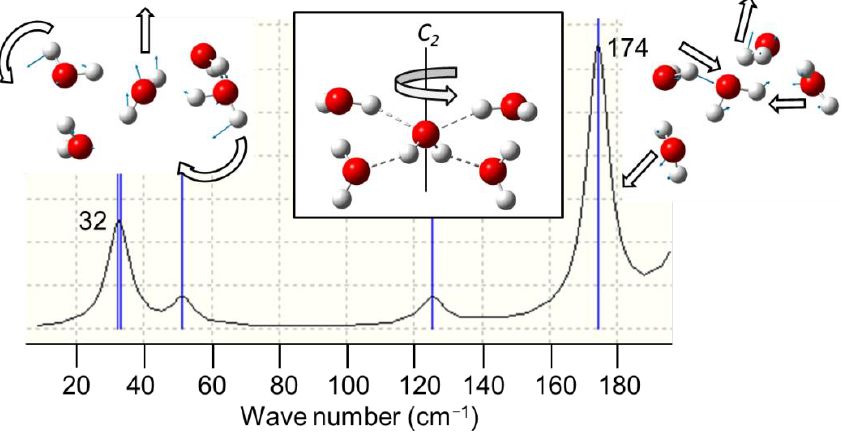
Figure 5. Hydrogen-bonded water pentamer with C (IR) spectrum calculated at Becke’s three parameter exchange and Lee–Yang–Parr correlation functional (B3LYP)/the correlation consistent polarized valence triple-zeta (cc-pVTZ)